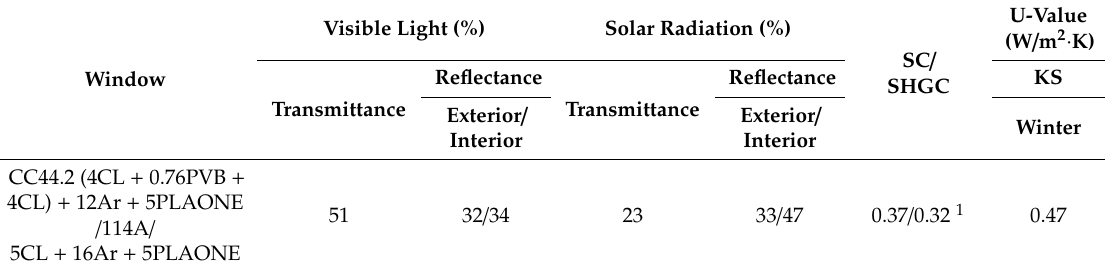
Table 3. Window (Glazing) specification in testbed without SPD